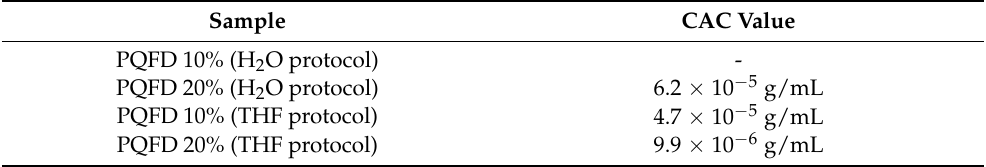
Table 2. AC values for PQFD amphiphilic copolymer solutions prepared by the H 2 O and THF